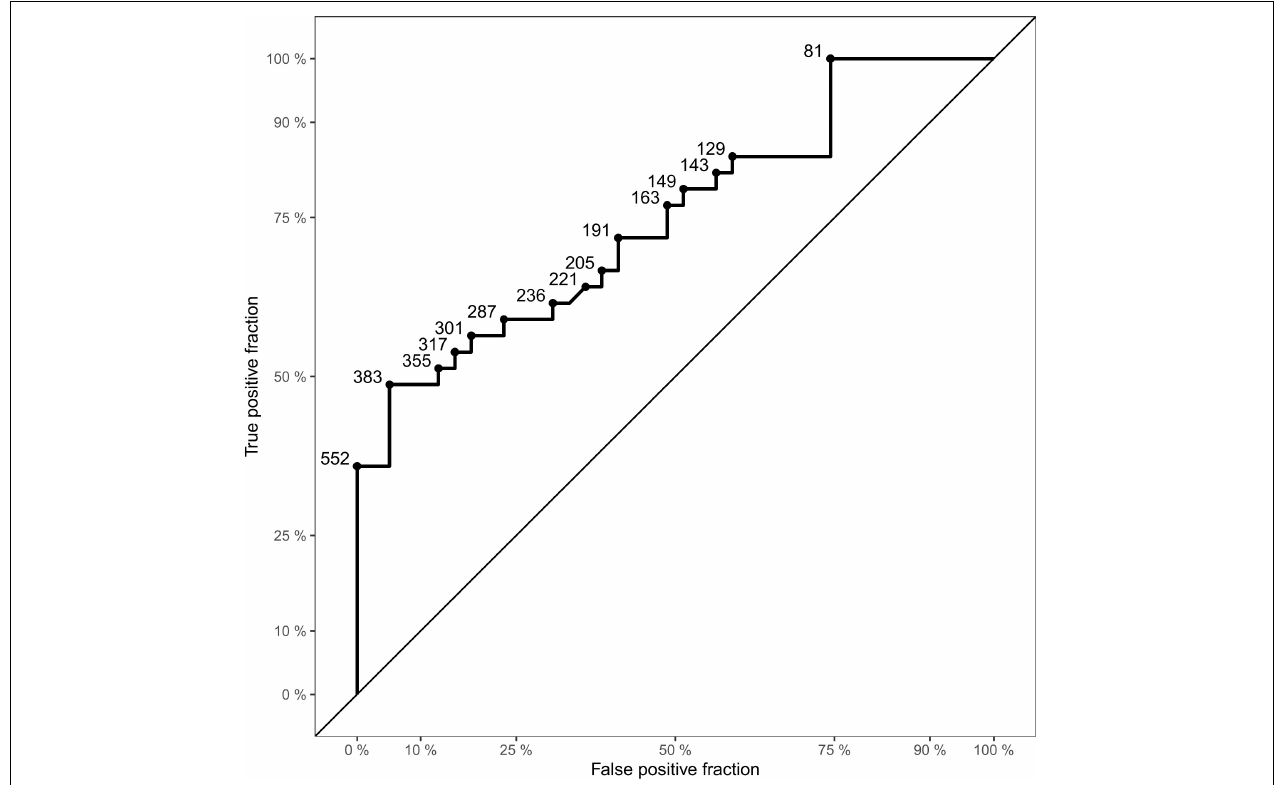
FIGURE 3 | Receiver Operating Characteristic (ROC) curve of the dataset. Displaying sensitivity (true positive fraction) in the y -axis and 1-specificity (false positive fraction) on the x -axis. Points on the curve show examples of cut-off values (aerosol particles per